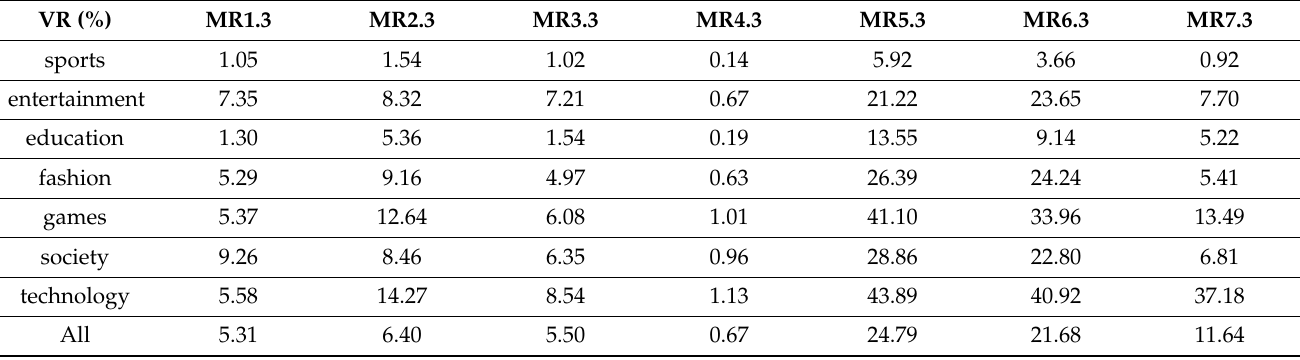
Table 9. AliNLP text classification